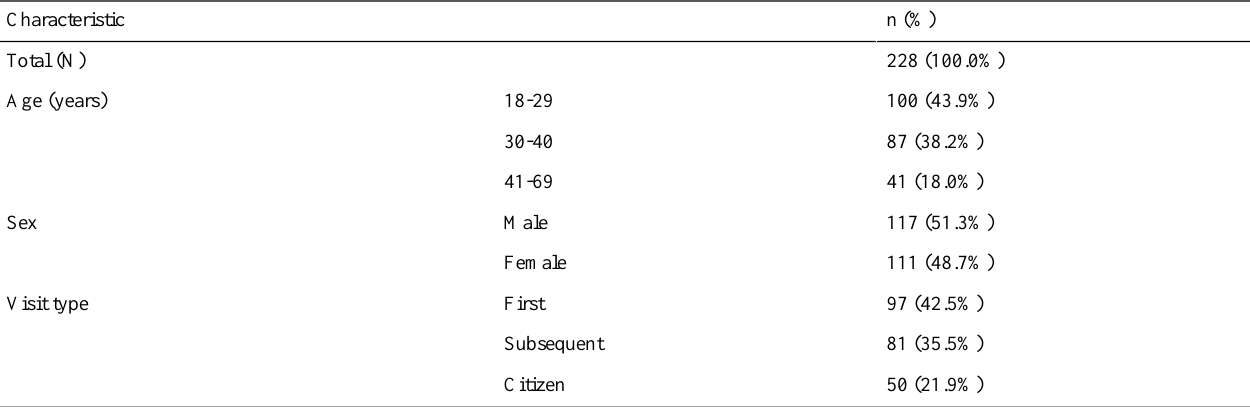
Table 1. Participant demographics of the Part A